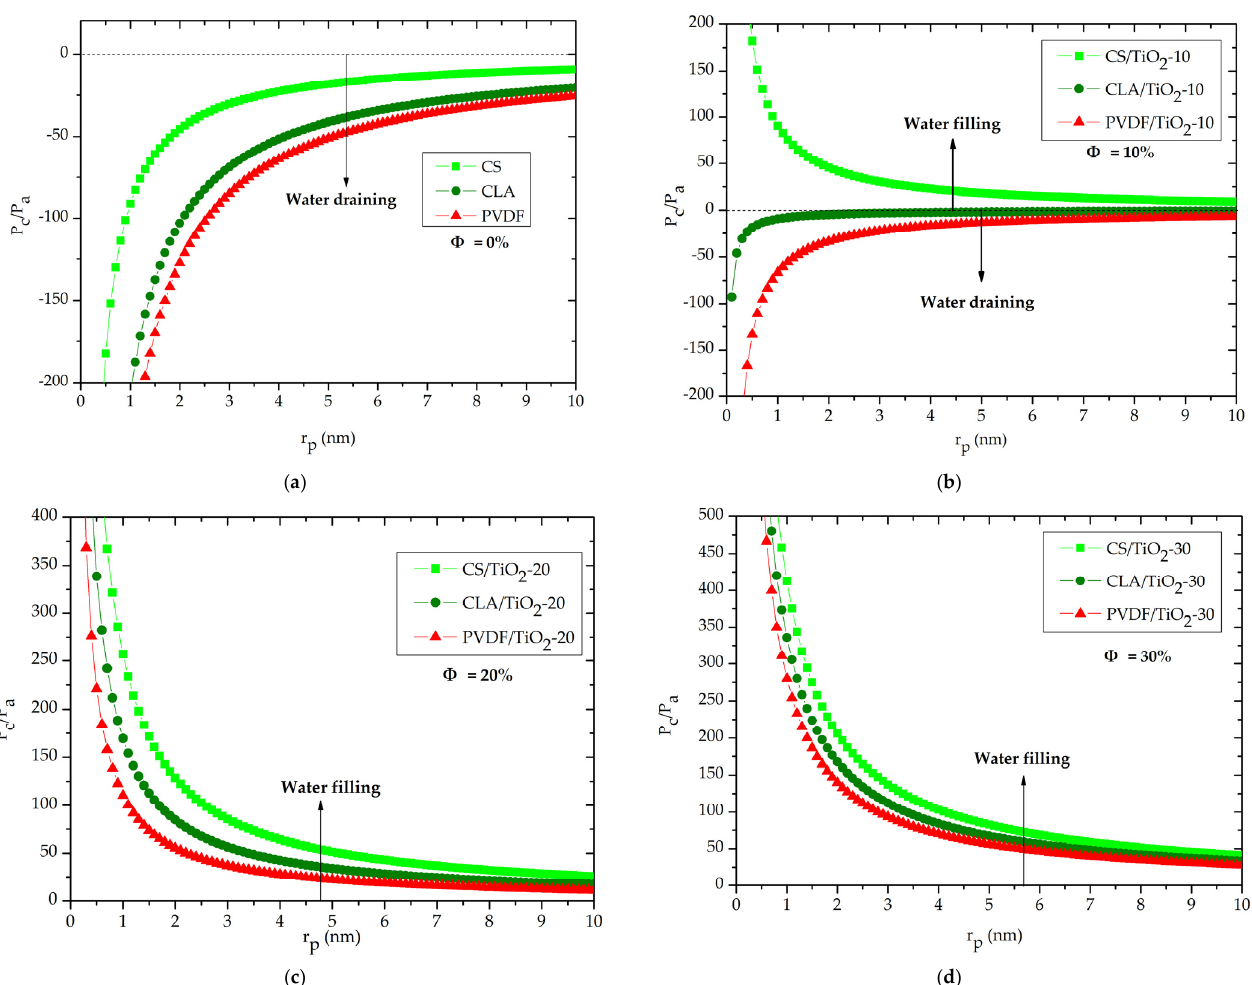
Figure 4. Capillary pressure as function of the pore radius for CS/TiO 2 , CLA/TiO 2 and PVDF/TiO 2 : ( a ) Ф = 0%, ( b ) Ф = 10%, ( c ) Ф = 20%, ( d ) Ф = 30%.